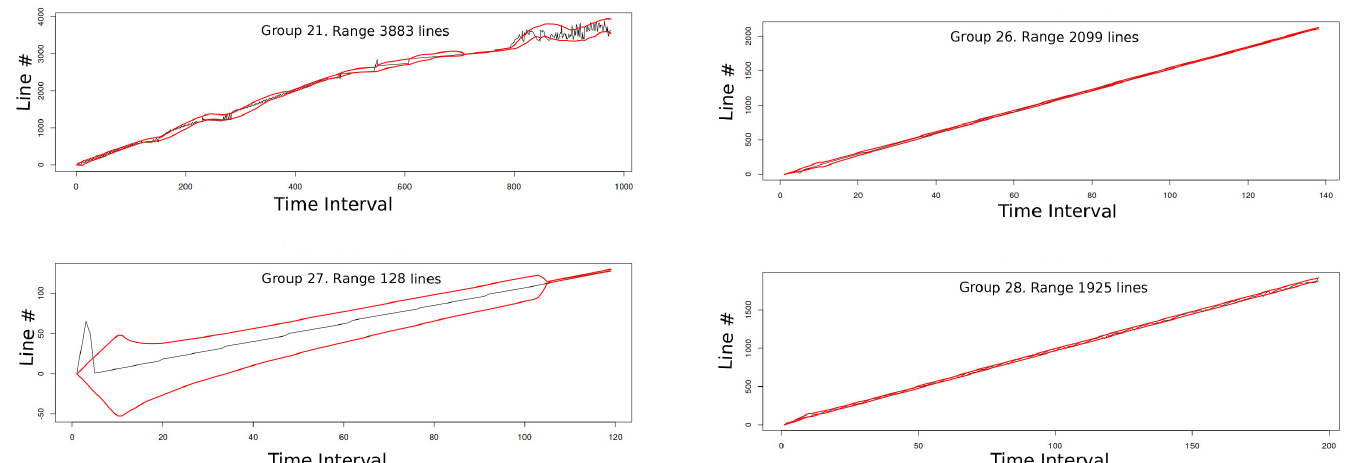
Fig 9. Main areas of spatial locality in astar with recognized intervals. Based on the group identification, HMM gets address intervals with high probability of use, which are shown in this figure between the red lines.